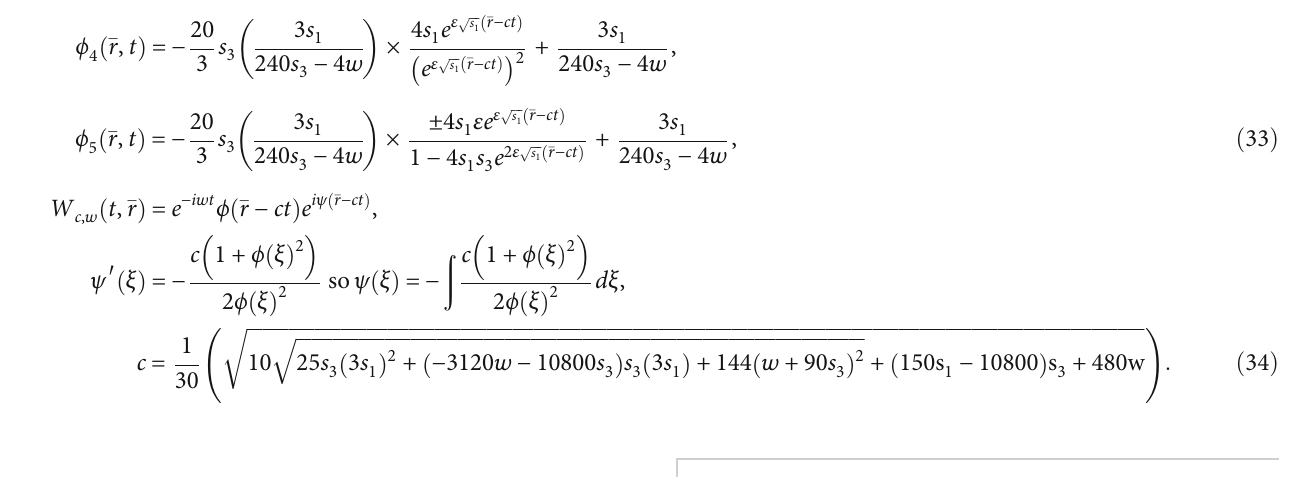
ð (cid:1) r , t Þ , for (cid:1) r , t = − π :: π , s 7